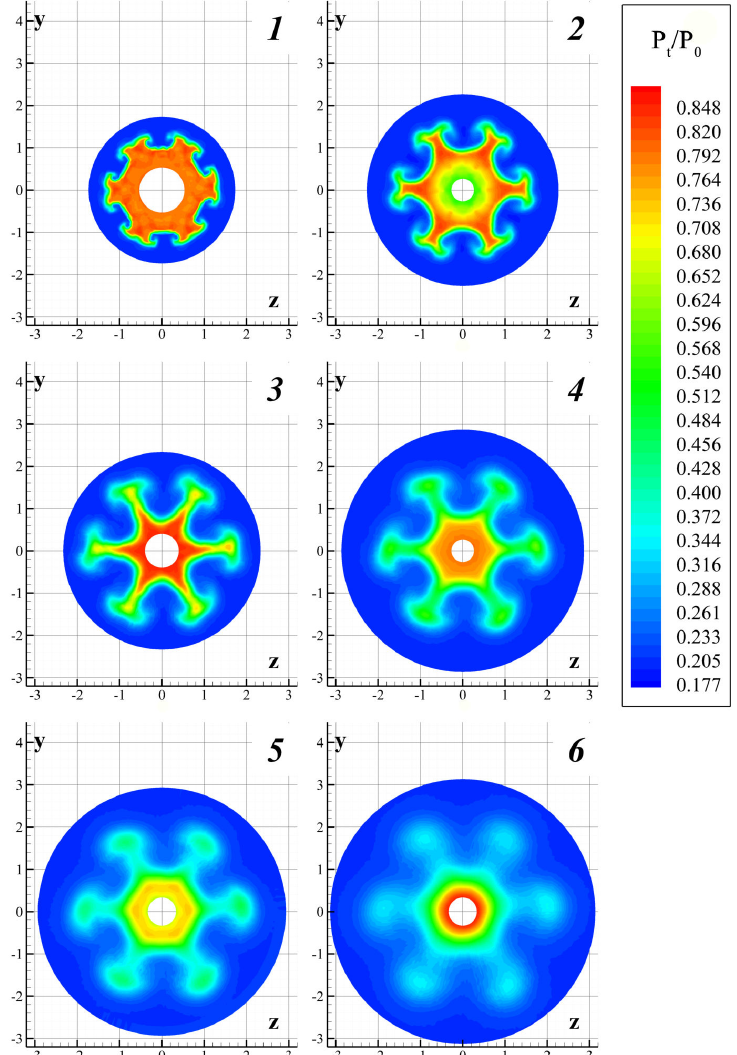
Figure 7. Azimuthal distributions of relative pressure measured in several cross-sections of the jet: x/R a = 1.0 ( 1 ), 2.0 ( 2 ), 3.0 ( 3 ), 4.0 ( 4 ), 5.0 ( 5 ), and 6.5 ( 6